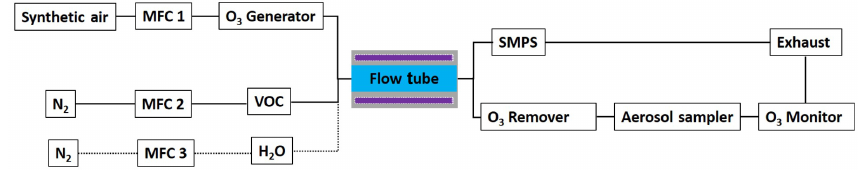
Figure 1. Schematics of the experimental setup for generation and collection of SOA